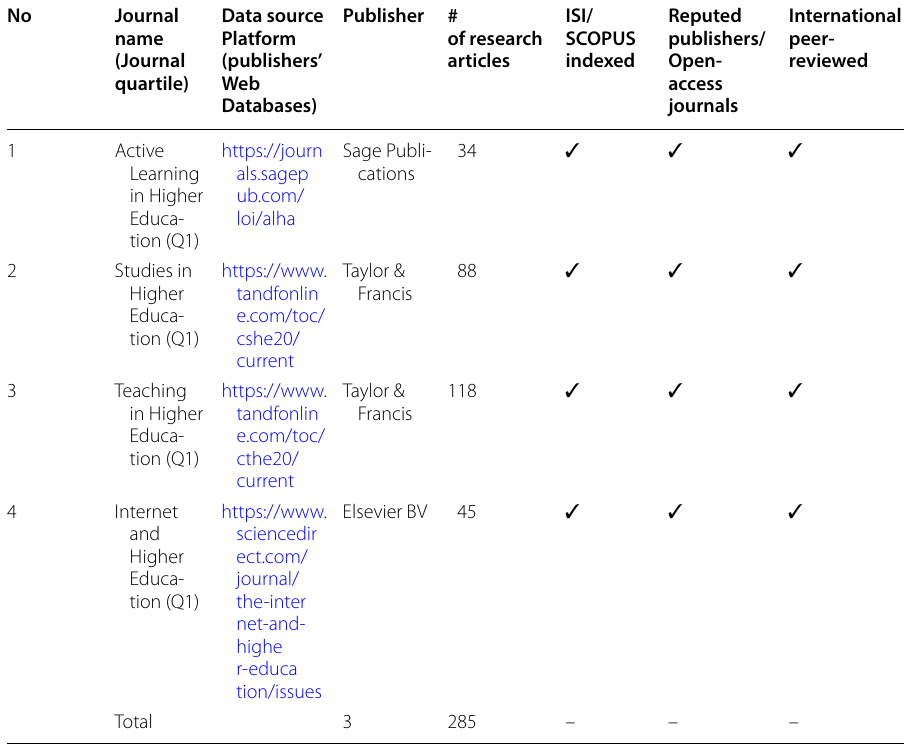
Source: Scimago (www.scima gijr.com) and each journal